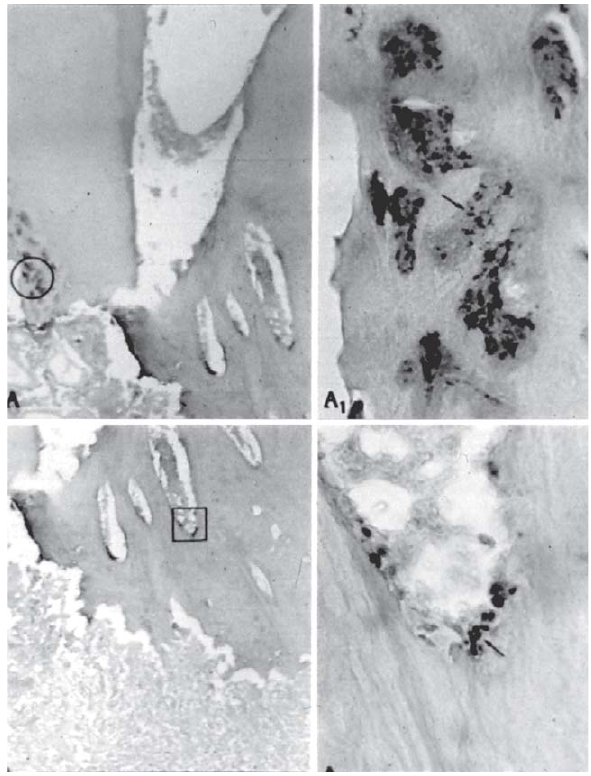
FIGURE 1- Group I: A- Microorganisms in cementum lacunae (circle) and canals of the apical delta - 125x. A1- Innumerable gram-positive cocci and bacilli can be seen - 1000x. A2- Canals of the apical delta (square) with microorganisms – 125x. A3- Presence of yeast - 1000x. Brown & Brenn staining